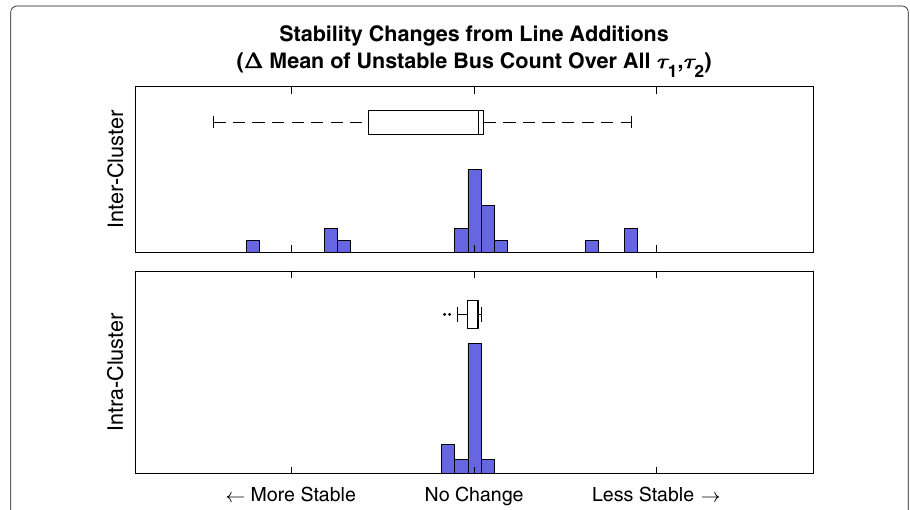
Fig. 10 Distributions of Stability Change Parameter: Inter- vs. Intra-Community. Distributions of stability impact parameter for a) inter-community connections, and b) intra-community connections. From the histogram outliers and the spread denoted by the box plot width, it is clear that the line additions